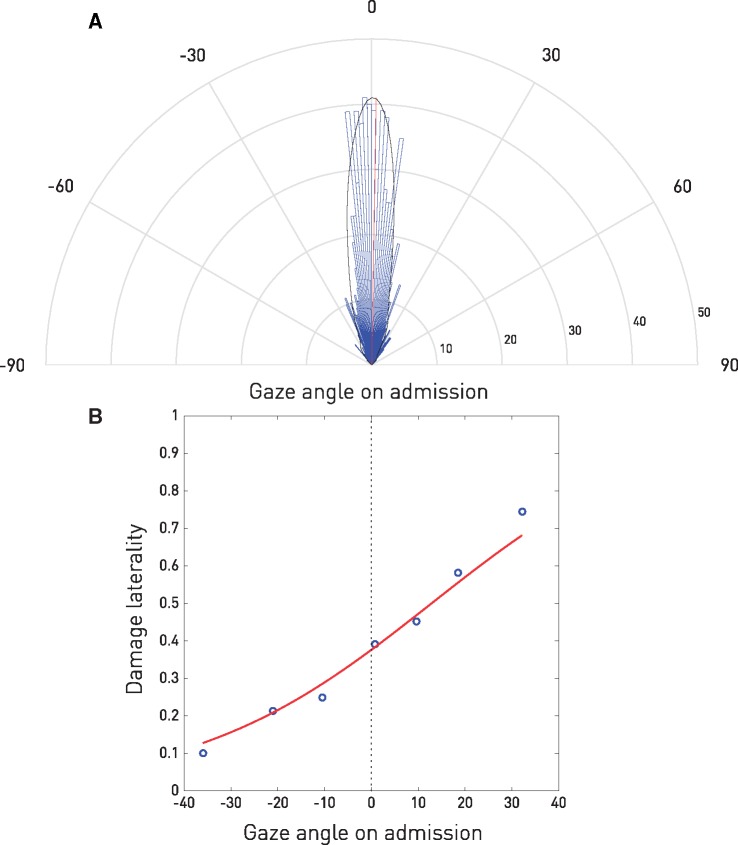

Distribution of patient gaze on admission. (A) Polar plot of the histogram (blue) and kernel density estimate (black) of the distribution of patient gaze on admission as determined by semi-automated segmentation of the intraocular lenses visualized on the CT scan. Note the circular mean (red) is within <1° of the midline (0.93°). (B) Relation between the admission direction of gaze and the laterality of brain damage. For each of seven bins of gaze angle, the mean ratio of the volume of right hemisphere damage to the overall volume of damage is plotted (blue), with a general linear model maximum likelihood fit of the relation across gaze (red). The remarkably strong dependence of gaze on damage laterality shows the variation in gaze shown in A is unlikely to be dominated by noise. See Supplementary material.